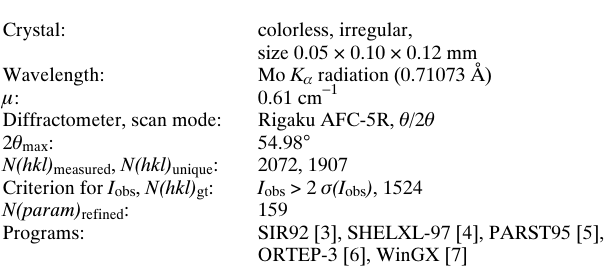
Table 1. Data collection and handling.